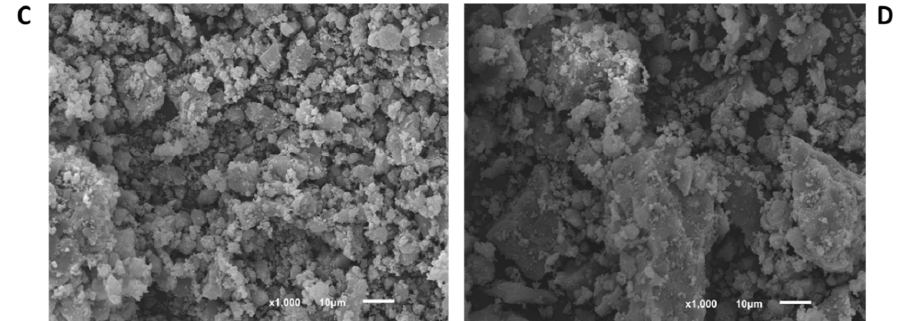
Figure 2. SEM images of Basolite F300 (zoom in 10 µm) ( A : original, B : 55.9 MPa, C : 111.8 MPa, D : 186.3 MPa).